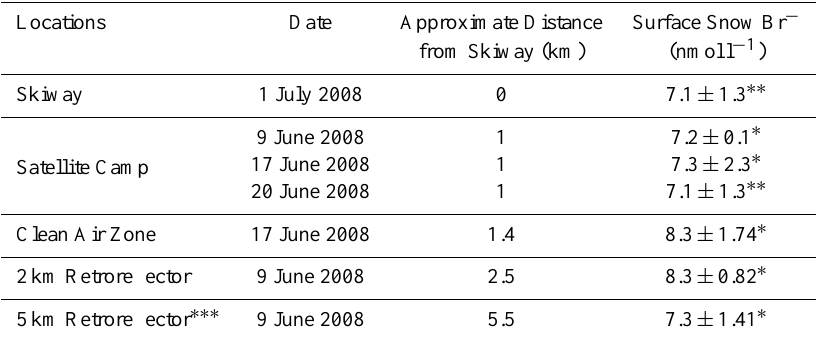
Table 1. Surface snow bromide concentrations at different distances from the skiway at Summit in 2008 (see also Fig. 1). No dependence of surface Br − concentrations on distance to the skiway or station (approximately between runway and satellite camp) was found. Please refer to Dibb et al. (2010) for details on the sampling and analytical